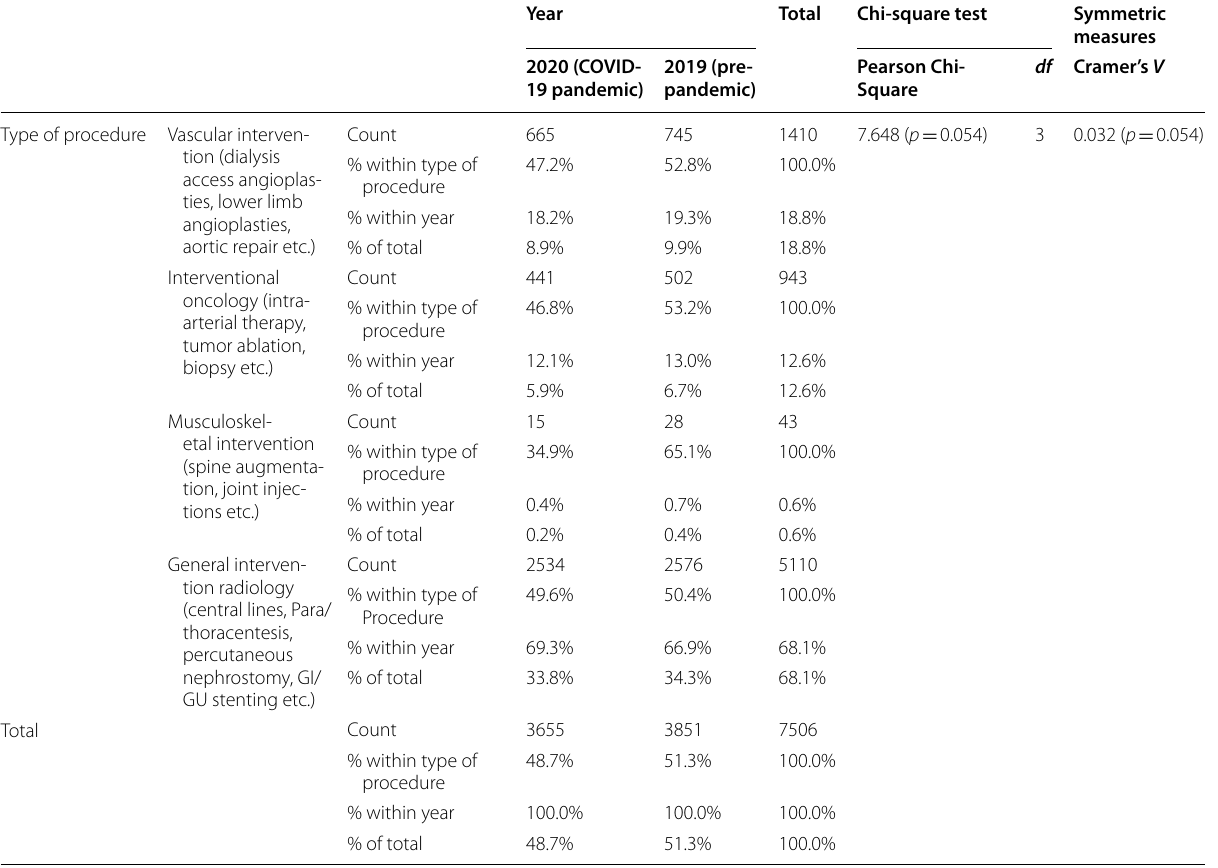
Table 2 (2020 and 2019: categories of IR procedures)